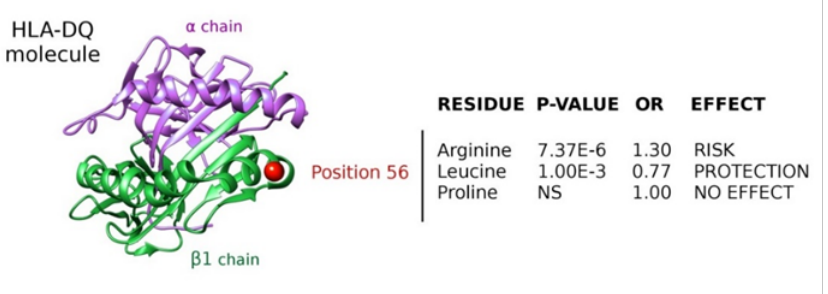
Figure 2. Ribbon representation of the HLA-DQ molecule. The most associated amino acid position with nonobstructive azoospermia susceptibility is highlighted with a red sphere. P -values, odds ratios (ORs), and the e ff ect conferred by the di ff erent residues at that position are also shown. Data obtained from Huang et al.